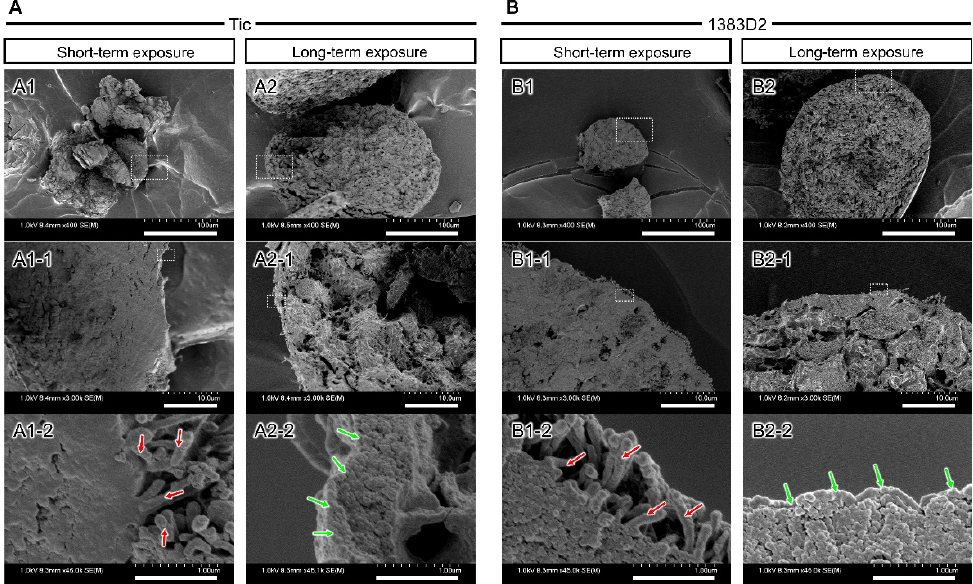
Figure 6. Scanning electron microscopic images of cross-sectional structure of the cell aggregates formed by short- and long-term exposure conditions at 120 h (( A ), Tic; ( B ), 1383D2). Panels ( A1-1 – B2-1 , A1-2 – B2-2 ) show magnified views of the boxed area. Green arrows and red arrows indicate particle structures and fibril structures, respectively. Scale bars: 100 μ m ( A1 – B2 ), 10 μ m ( A1-1 – B2-1 ), 1 μ m ( A1-2 – B2-2 ).